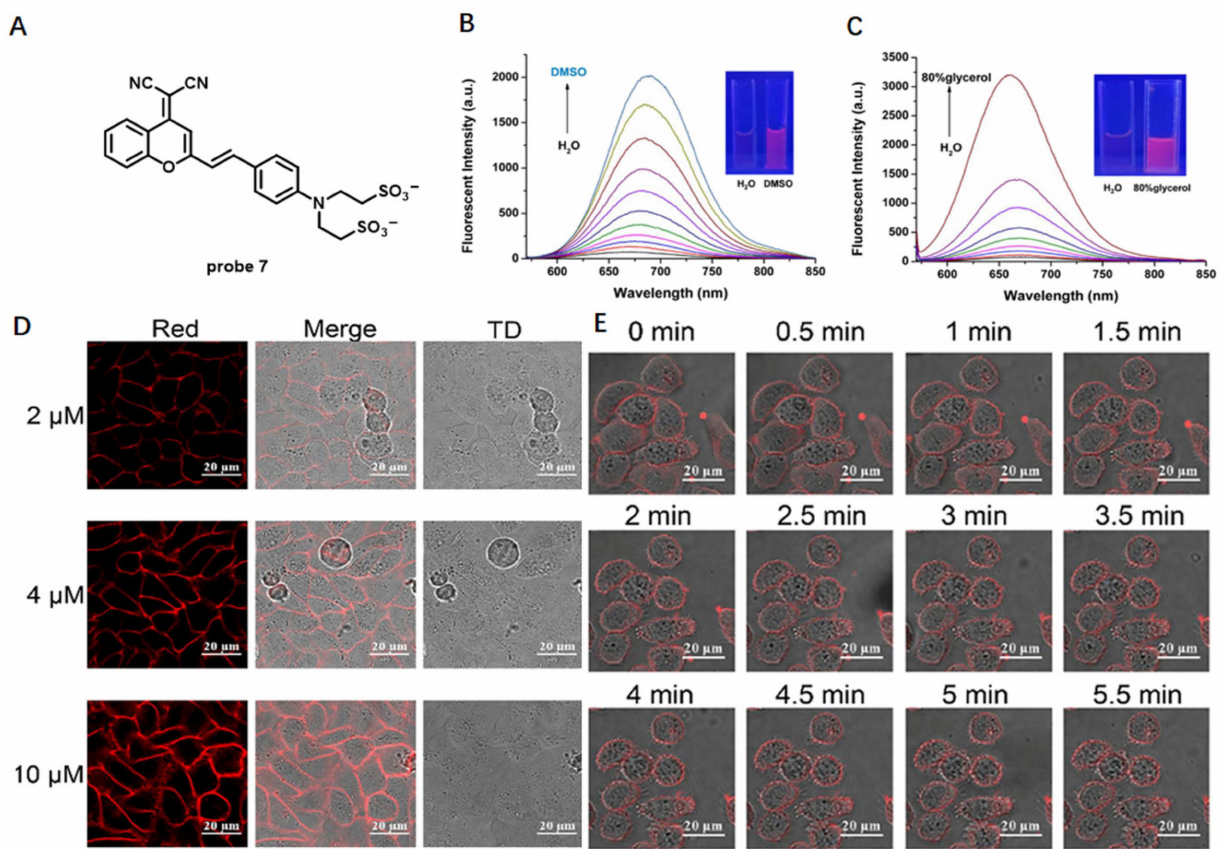
Figure 6. ( A ) Chemical structure of probe 7 . ( B , C ) Fluorescent spectra of probe 7 in different conditions. ( D ) HeLa CM imaging using different concentrations of probe 7 . ( E ) The imaging of detachment process of adherent cells using probe 7 . Scale bar: 20 µ m. Copyright 2020 American Chemical Society